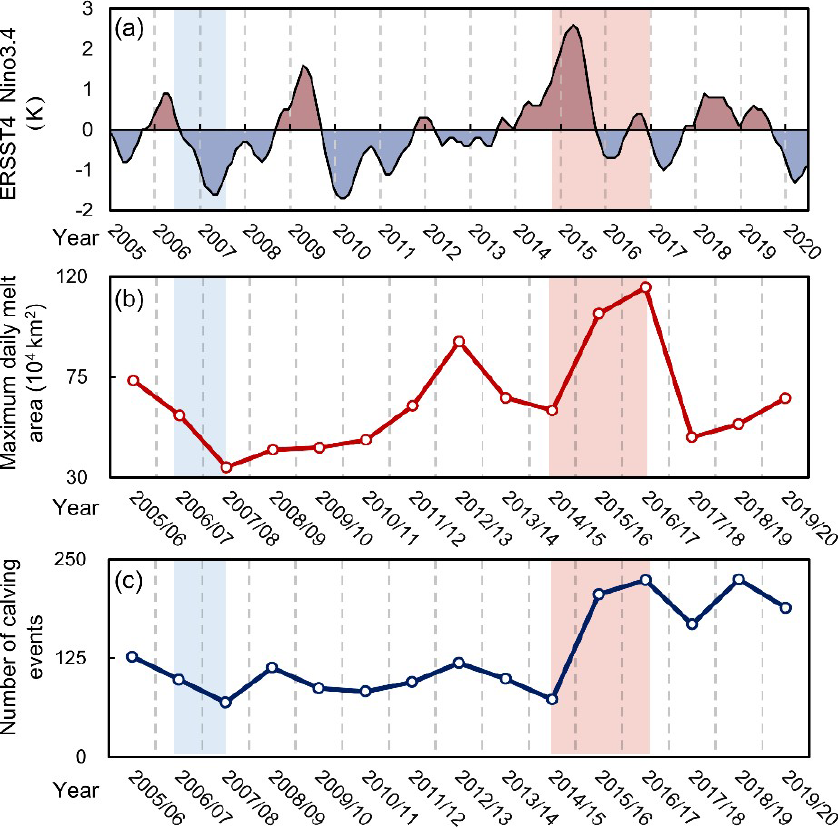
Figure 9. Relationship between annual iceberg calving distribution for 2005–2020 and (a) oceanic Niño index data from https://ggweather. com/enso/oni.htm (last access: 11 September 2021) and (b) maximum daily ice sheet surface melting area data from http://pp.ige-grenoble. fr/pageperso/picardgh/melting/ (last access: 11 September